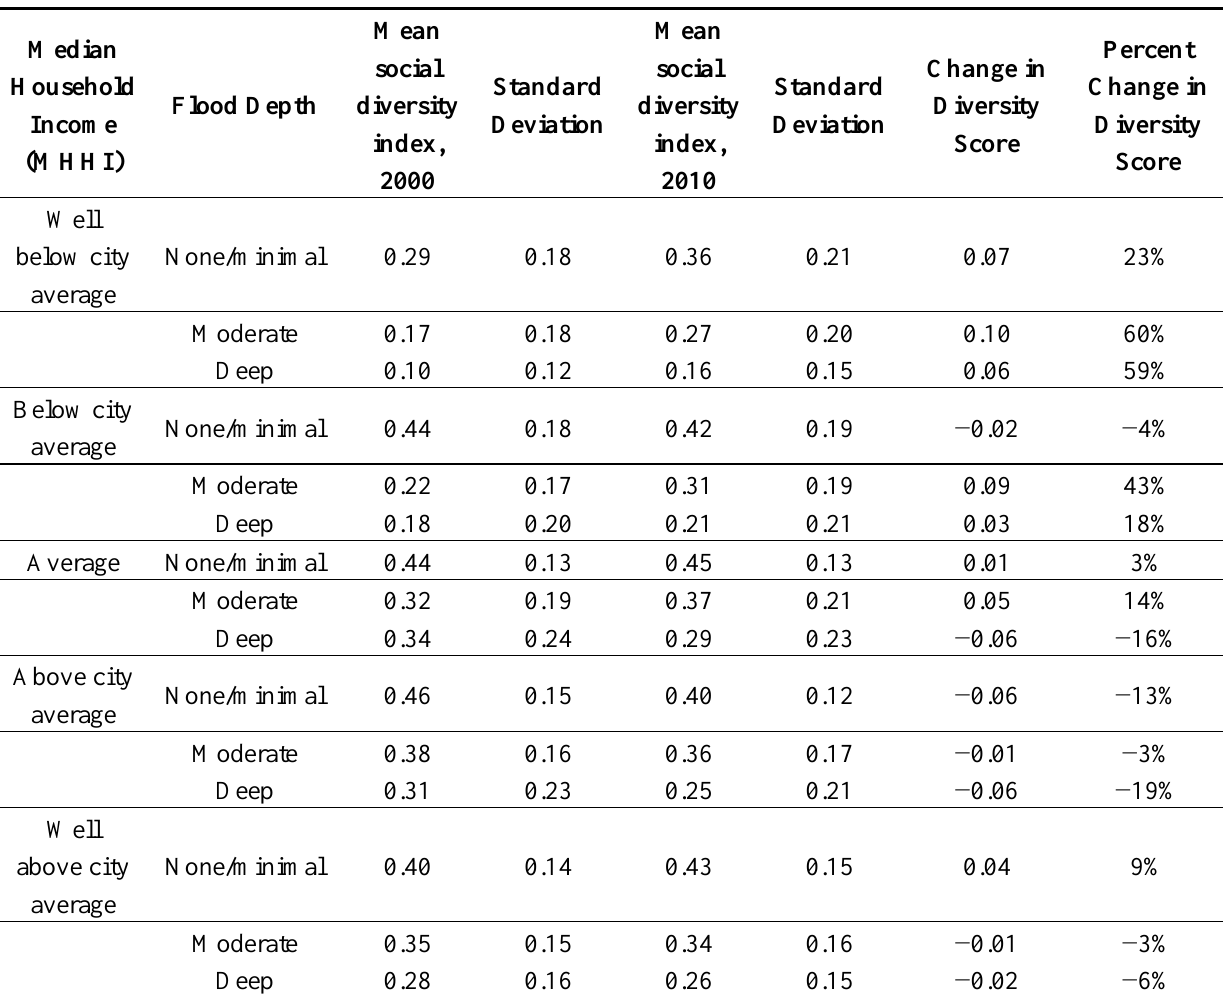
Table 2. Median household income, flood damage, and change in social diversity index by census blockgroup,